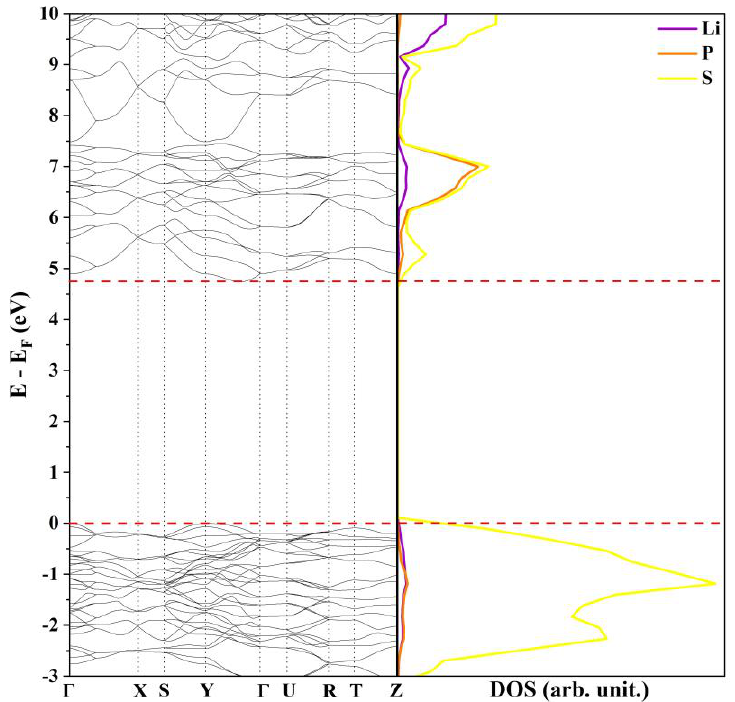
Figure 1. Band structure and density of states of β -Li 3 PS 4 Pn2 1 a at the PBE0 level.